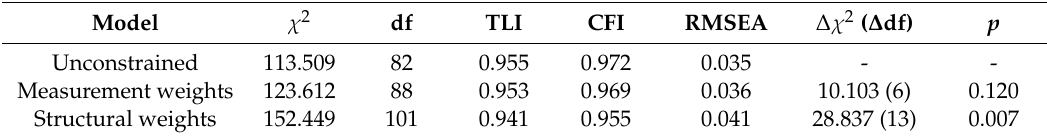
Table 4. Testing for measurement invariance between sexes.